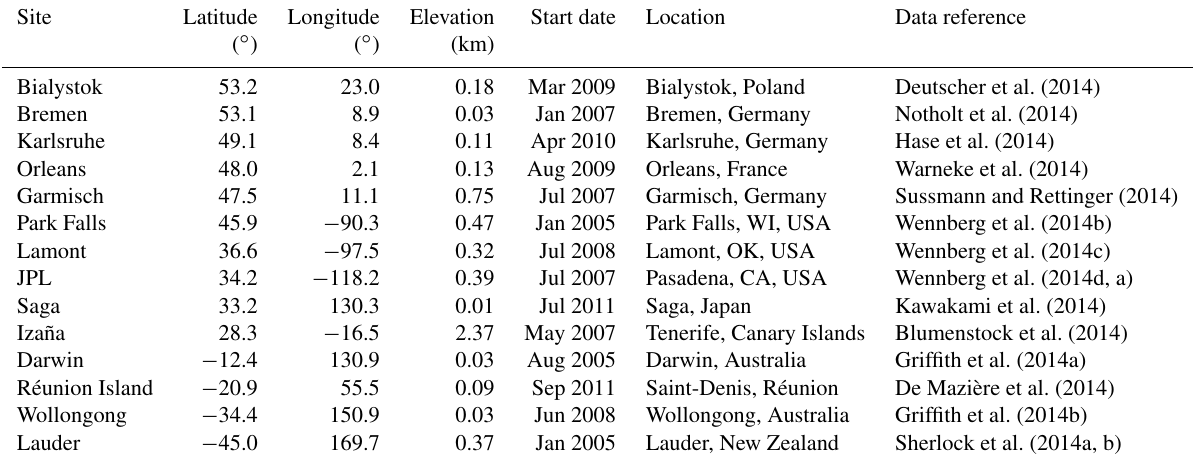
Table 1. TCCON sites, coordinates, altitudes, start date of measurements and locations used in this analysis. Site